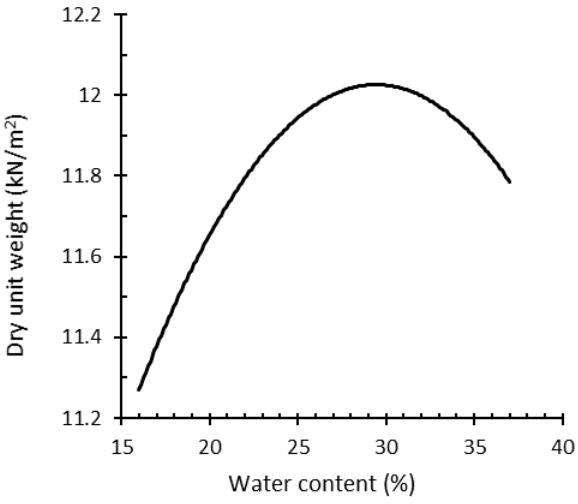
Figure 2 Standard Proctor compaction curve for extracted peat soil: